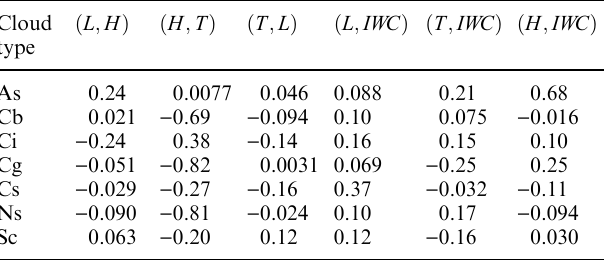
Table 4. Correlation coe(cid:129)cients Cloud